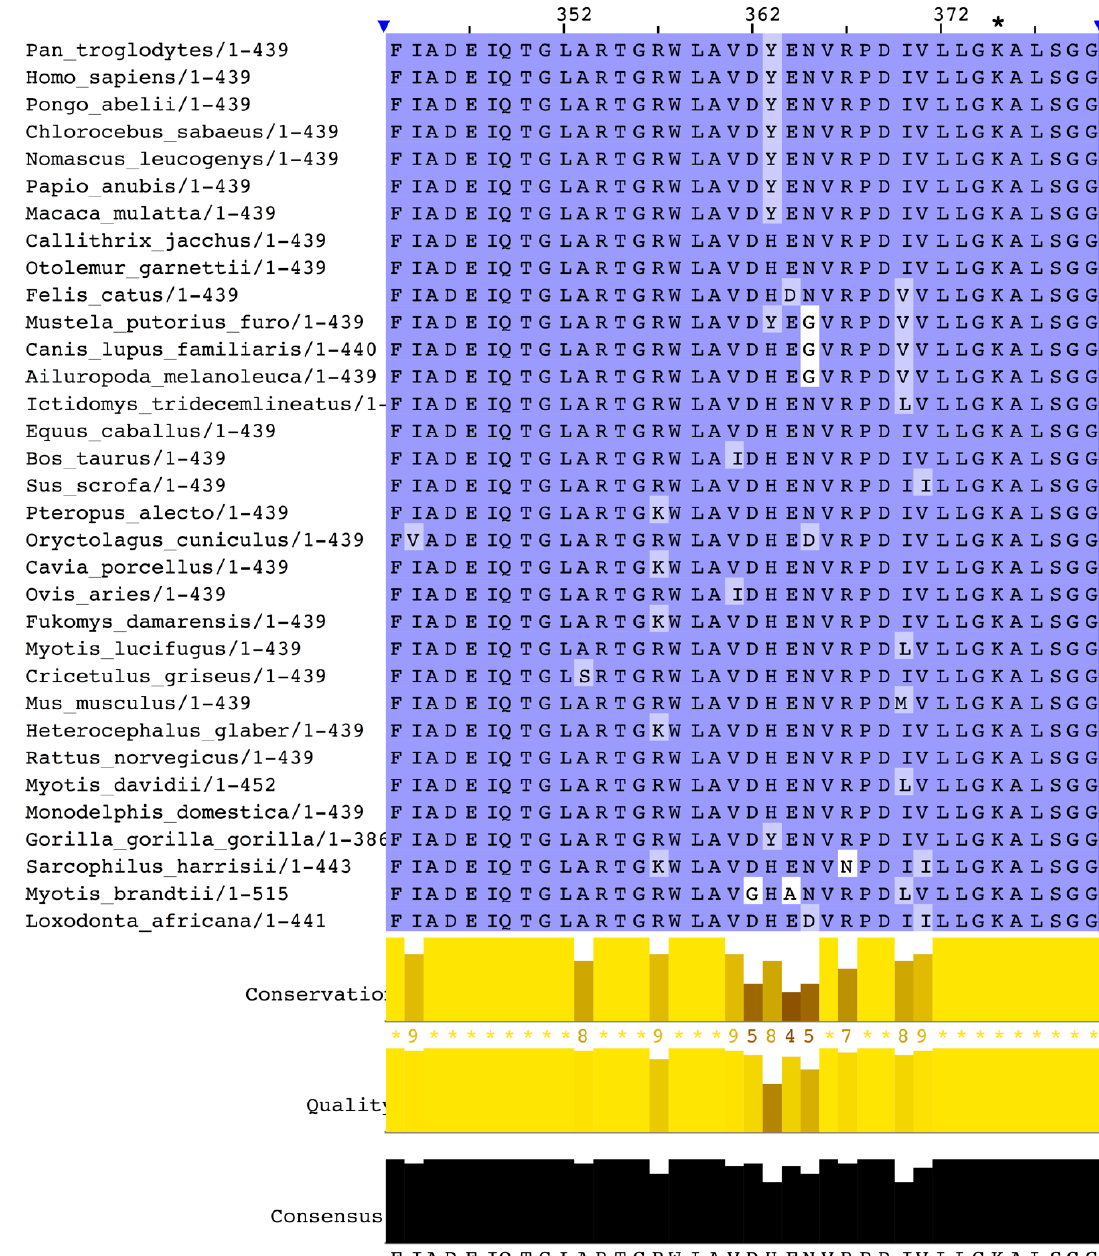
Figure 6. Close-up of the Prosite consensus pattern region of the Clustal multiple alignment of mammalian OAT sequences. The pyridoxal 5-phosphate (PLP) attachment site is the conserved lysine residue in column 375 of the alignment (denoted by an asterisk), which corresponds to residue 292 in the human sequence.